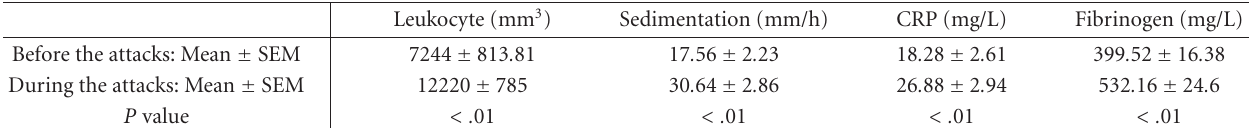
Table 1: Laboratory test before and during FMF attacks.